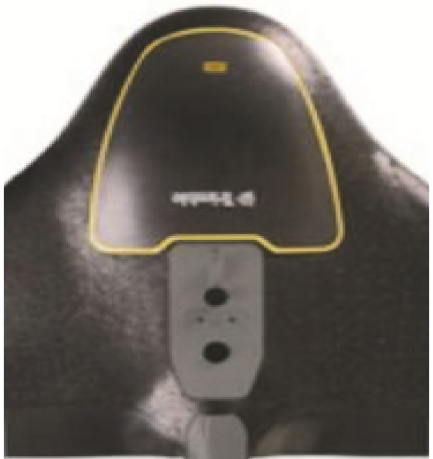
Figure 9: Structure of the UAV carrier antenna with carbon fiber